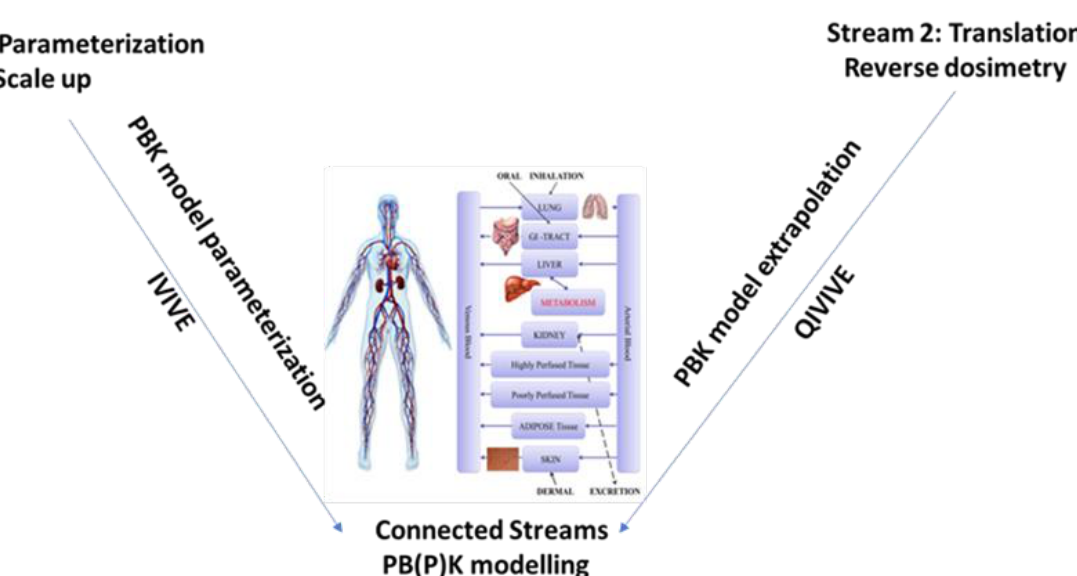
Figure 3. Components of IVIVE. Stream 1 (parameterization) scales up in vitro measures to param- eterize the PBPK model. Stream 2 (translation) accounts for the chemical’s availability in vivo and in vitro. (Part of NAM-02 presentation, Supplemental File).